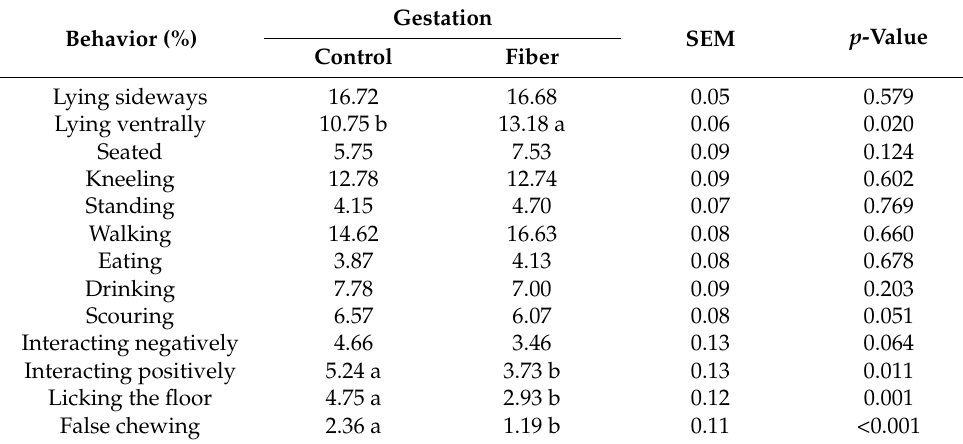
Table 9. Behavioral frequency (%) of sows in collective gestation (85th to 107th days of gestation) supplemented or not with dietary fiber in the